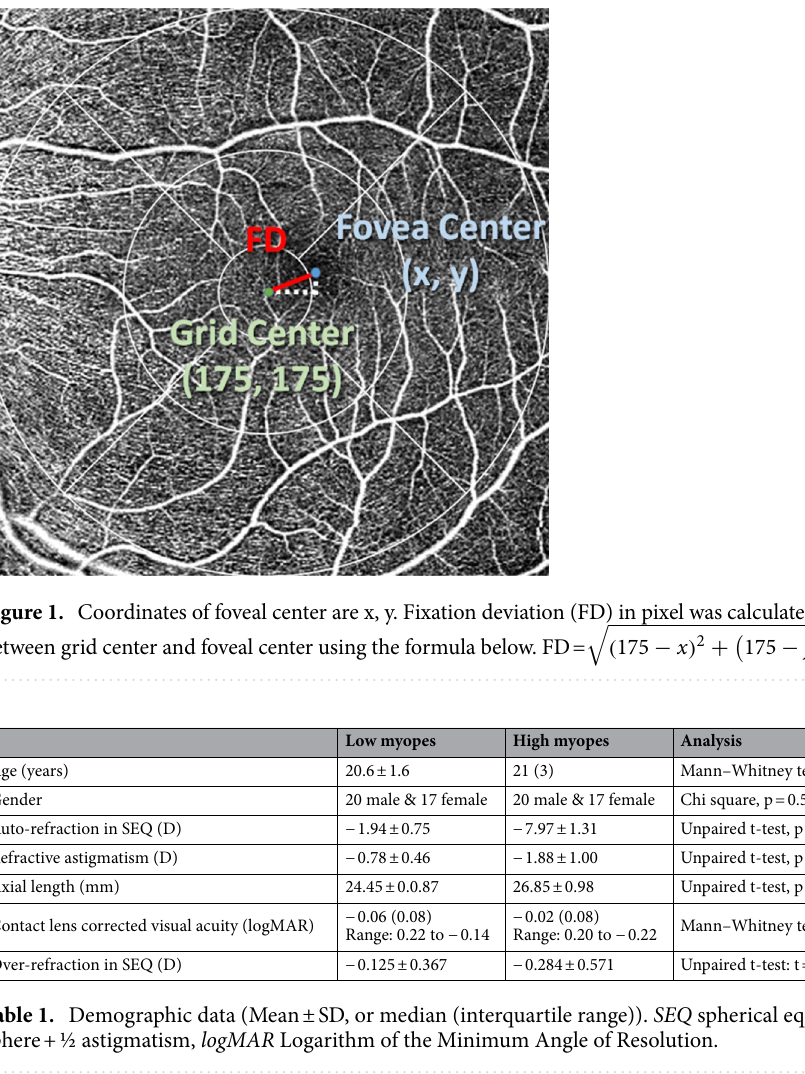
Table 1. Demographic data (Mean ± SD, or median (interquartile range)). SEQ spherical equivalent, sphere + ½ astigmatism, logMAR Logarithm of the Minimum Angle of